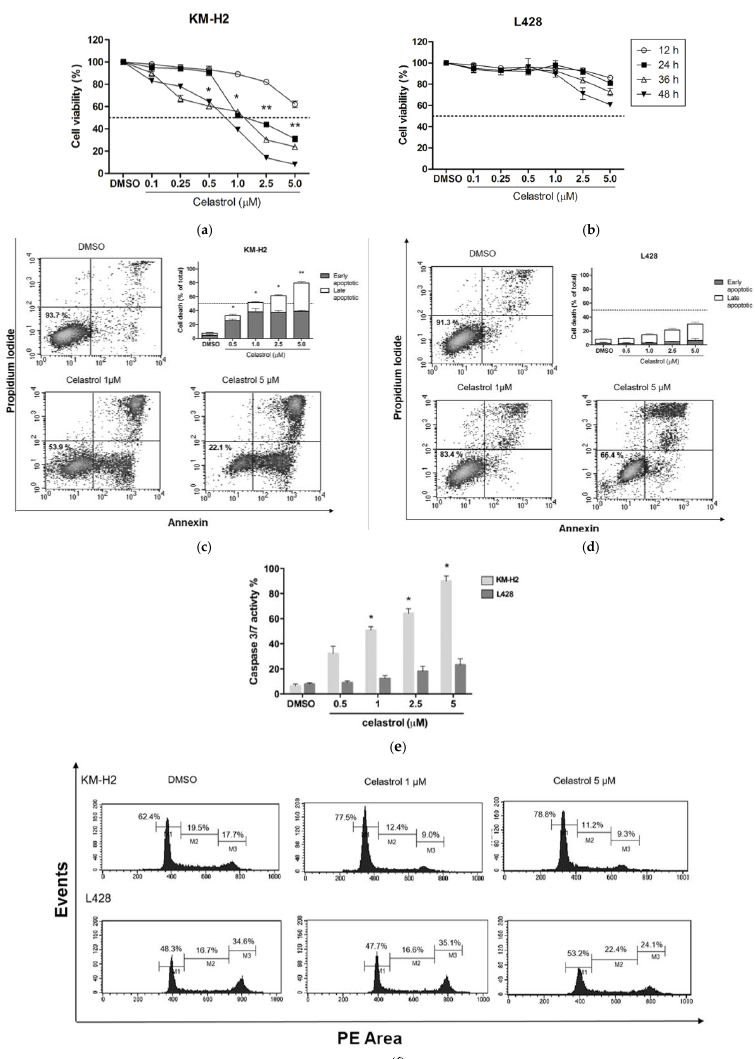
Figure 1. Effects of celastrol on KM-H2 and L428 cells. KM-H2 ( a ) and L428 ( b ) cell lines were treated with the indicated concentrations of celastrol or with the vehicle control (Dimethyl sulfoxide; DMSO) for 24, 48, and 72 h, and cell viability was detected by WST-1 assay (4-[3-(4-iodophenyl)-2-(4-nitrophenyl)-2 H -5-tetrazolio]-1,3-benzene disulfonate sodium salt). Apoptosis of KM-H2 ( c ) and L428 ( d ) cell lines induced by celastrol (0.5, 1, 2.5, and 5 µM) was measured by the Annexin V assay after 24 h. Cell lines incubated with vehicle control (DMSO) were used as a control of spontaneous apoptosis. The images are representative of three independent experiments, and the means and errors of all the independent experiments are shown in the bar chart. The percentage of celastrol-induced cell death was calculated by subtracting the rates of spontaneous death determined in the control from the overall cell death rate in celastrol-treated samples for each dose point. The cells that were annexin V (+) and PI ( − ) were considered early-stage apoptotic cells, while annexin V (+) and PI (+) cells were considered to be in late-stage apoptosis; ( e ) profile of caspase-3/7 activation mediated by celastrol in KM-H2 and L428 cells. The percentage of caspase-3/7 activation was calculated by subtracting the values of caspase-positive samples from the negative control sample (DMSO); ( f ) changes in cell cycle induced by celastrol in KM-H2 and L428 cells. The cell lines were exposed to the indicated concentrations of celastrol and to DMSO and collected after a 24 h exposure. One experiment representative of three independent experiments is shown. The values represent the average of three independent experiments. The error bars represent ± standard error (* p < 0.01; ** p <